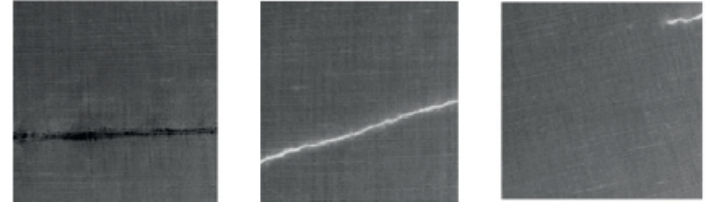
Fig. 8 Typical missed detection pattern under the colour moment algorithm.